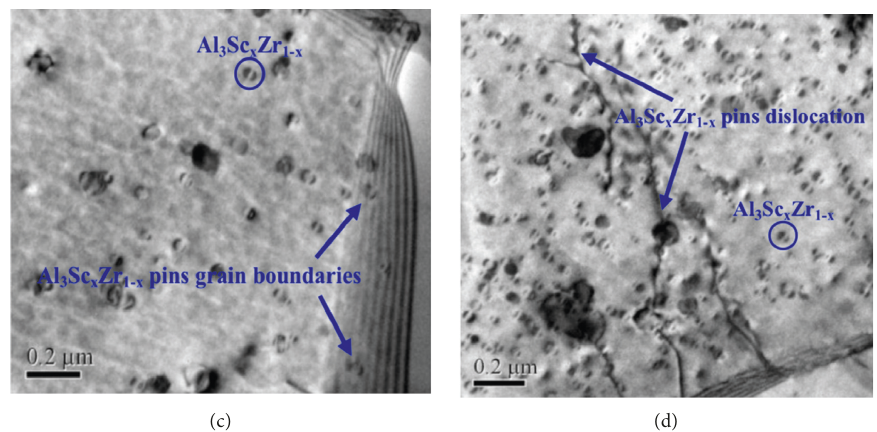
Figure 7: TEM microstructures of superplastically deformed Al-Zn-Mg-Sc-Zr alloy [42, 56].